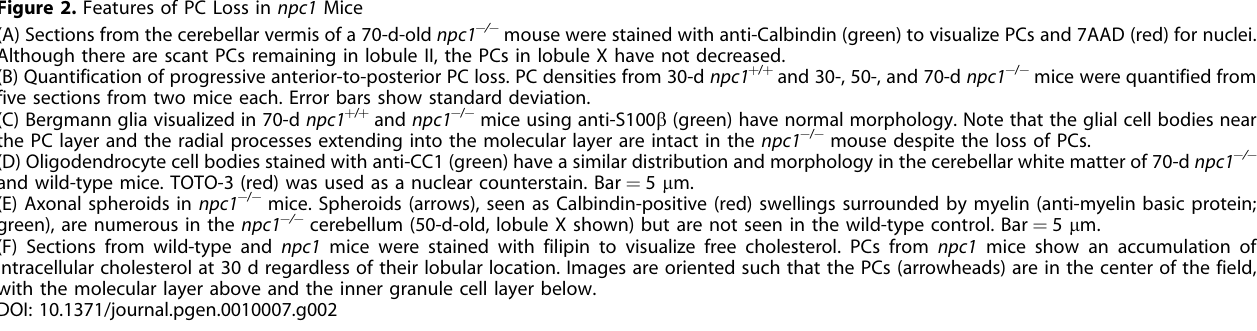
Figure 2. Features of PC Loss in npc1 Mice (A) Sections from the cerebellar vermis of a 70-d-old npc1 (cid:1) / (cid:1) mouse were stained with anti-Calbindin (green) to visualize PCs and 7AAD (red) for nuclei. Although there are scant PCs remaining in lobule II, the PCs in lobule X have not decreased. (B) Quantification of progressive anterior-to-posterior PC loss. PC densities from 30-d npc1 þ / þ and 30-, 50-, and 70-d npc1 (cid:1) / (cid:1) mice were quantified from five sections from two mice each. Error bars show standard deviation. (C) Bergmann glia visualized in 70-d npc1 þ / þ and npc1 (cid:1) / (cid:1) mice using anti-S100 b (green) have normal morphology. Note that the glial cell bodies near the PC layer and the radial processes extending into the molecular layer are intact in the npc1 (cid:1) / (cid:1) mouse despite the loss of PCs. (D) Oligodendrocyte cell bodies stained with anti-CC1 (green) have a similar distribution and morphology in the cerebellar white matter of 70-d npc1 (cid:1) / (cid:1) and wild-type mice. TOTO-3 (red) was used as a nuclear counterstain. Bar ¼ 5 l m. (E) Axonal spheroids in npc1 (cid:1) / (cid:1) mice. Spheroids (arrows), seen as Calbindin-positive (red) swellings surrounded by myelin (anti-myelin basic protein; green), are numerous in the npc1 (cid:1) / (cid:1) cerebellum (50-d-old, lobule X shown) but are not seen in the wild-type control. Bar ¼ 5 l m. (F) Sections from wild-type and npc1 mice were stained with filipin to visualize free cholesterol. PCs from npc1 mice show an accumulation of intracellular cholesterol at 30 d regardless of their lobular location. Images are oriented such that the PCs (arrowheads) are in the center of the